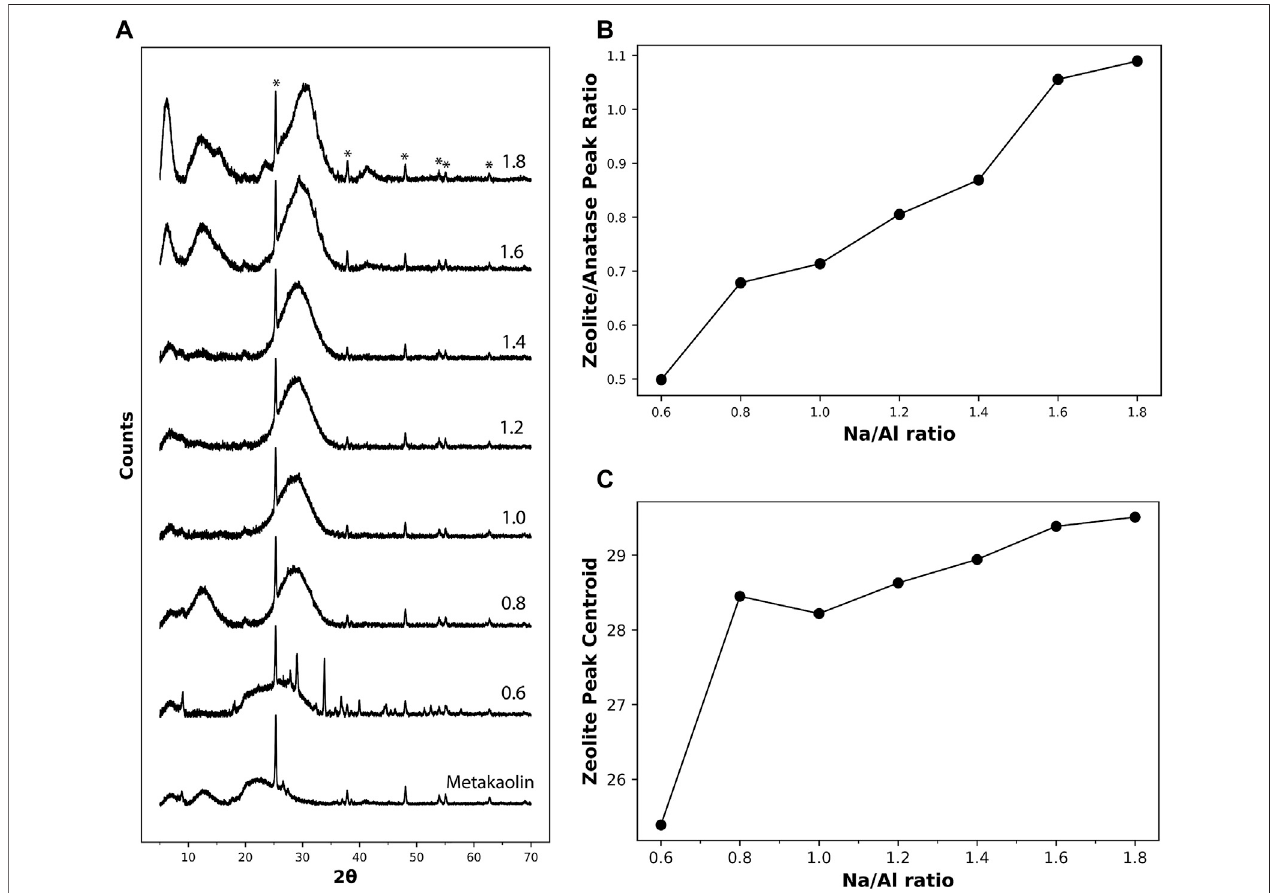
FIGURE 3 | (A) XRD diffractograms of metakaolin precursor and the different 3 month old AAM samples with Na/Al ratios ranging from 0.6 to 1.8. (B) The ratio between the height of the zeolite XRD hump at 2 θ ≈ 29 o and the anatase ’ s prominent peak at 2 θ ≈ 25 ° for the different samples. (C) The location of the centroid of the peak representing zeolites for the different Na/Al ratios. The peaks marked with (*) represent anatase (TiO 2 , PDF number 01-076-0325).